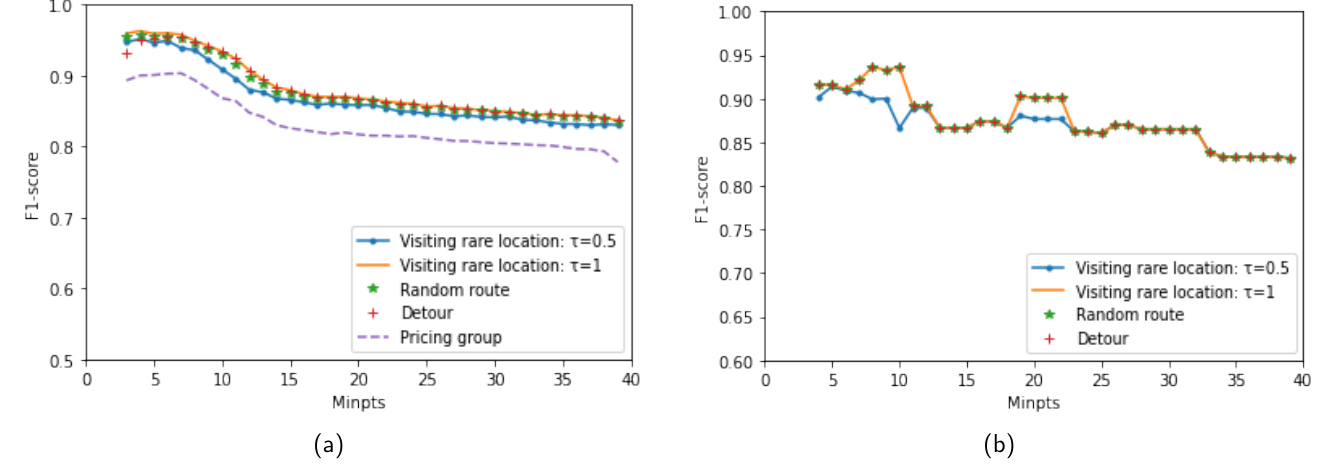
Figure 10. Performance of the proposed method when varying MinPts : ( a ) MIT Badge dataset. ( b ) sCREEN